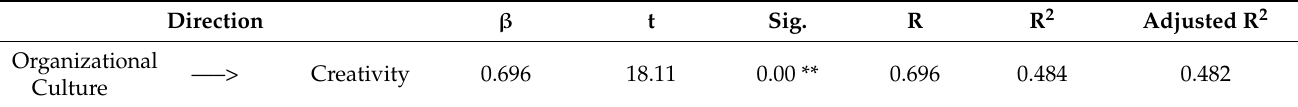
Table 8. Results of the analysis.